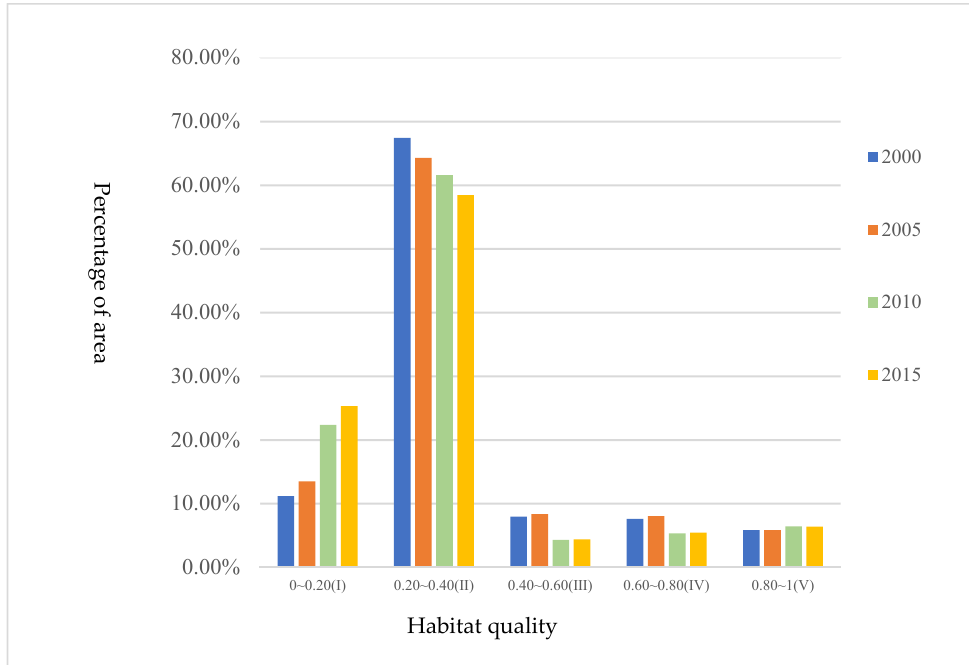
Figure 3. Spatial distribution of habitat quality during the different periods from 2000 to 2015.